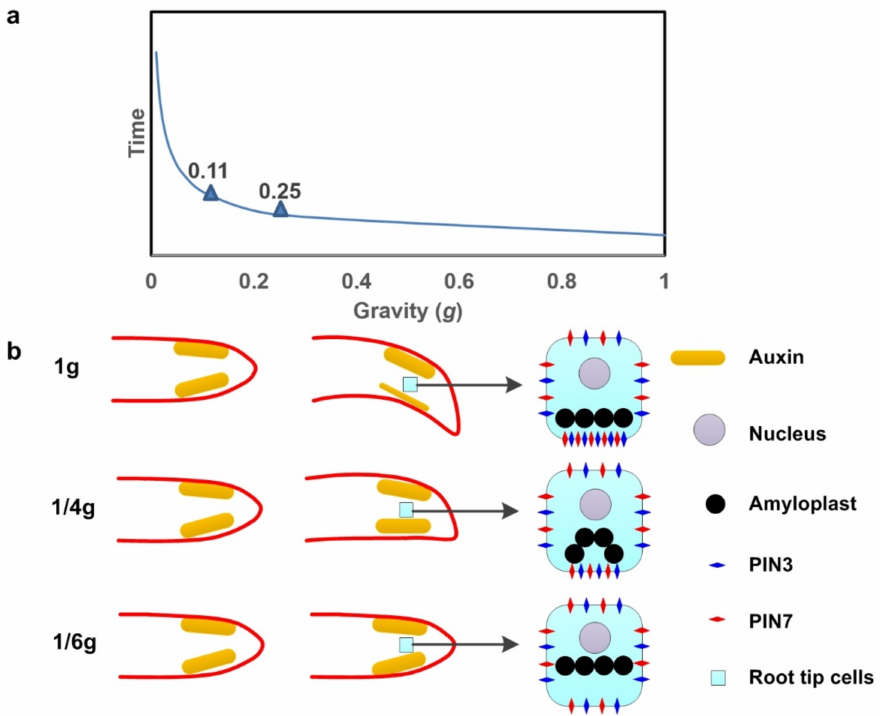
Figure 3. Dynamic model of amyloplast sedimentation in the cytoplasm. ( a ) The correlation between the descent velocity of amyloplast sedimentation in the cytoplasm and gravity variation. The two turning points at 0.25 g and 0.11 g indicate that the displacement of amyloplasts will be much slower under 0.25 g or less gravity. ( b ) At 1 g gravity, the amyloplasts in the columella cells fall to the lower side of the cell membrane, which is the key step in gravity sensing. The subsequent activation of PIN3 and PIN7 accumulation on the lower side of the cell membrane causes a rapid efflux of auxin. In this case, the auxin content on the upper side of the root tip is higher than the auxin content on the lower side, resulting in rapid growth of the cells in the upper part of the root tip. The root will grow in the direction of gravity. Under the 1/6 g gravity of the Moon, the amyloplasts in the root tip cells are insensitive to gravity and cannot sink to the lower part of the cell membrane rapidly. In this case, PIN3 and PIN7 are evenly distributed in the cell membrane. The auxin on both sides of the root tip is also uniformly distributed, causing the root tip to grow straight. The threshold calculated by the amyloplast precipitation model is 0.25 g. When gravity is less than 0.25 g, the sedimentation rate of the amyloplasts will be greatly reduced, and the root tip cannot bend and grow in response to